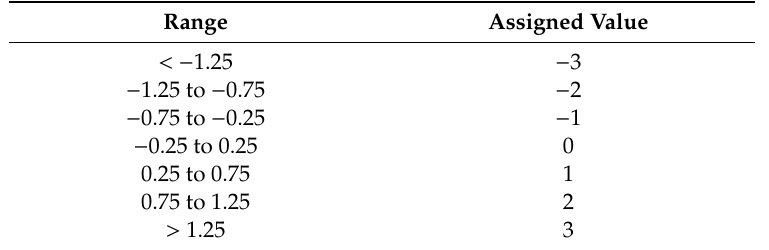
Table 3. Rules for assigning values when calculating the heat vulnerability index